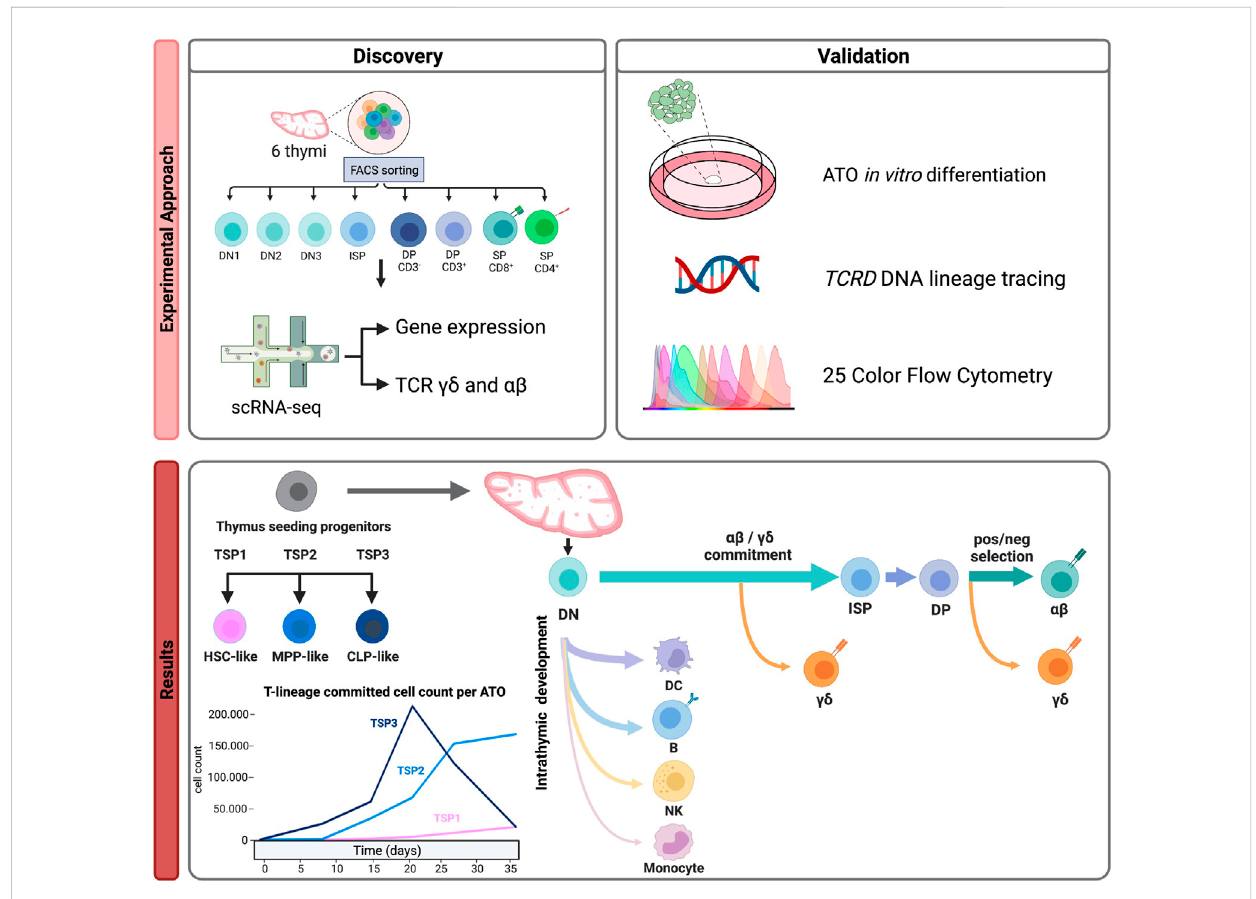
An example ofamulti-omicsapproachto understand human Tcelldevelopment (Cordes etal.,2022).Discovery: Puri fi cationof thymocyte subsets isolated from 6 healthy donors to generate a multi-omic (gene expression and γδ / αβ TCR) scRNAseq dataset resulting in the identi fi cation of different thymus seeding progenitor populations and detection of multiple lineage differentiation trajectories (including alternative lineages). Validation: by functional assays, lineage tracing and multi-color fl ow